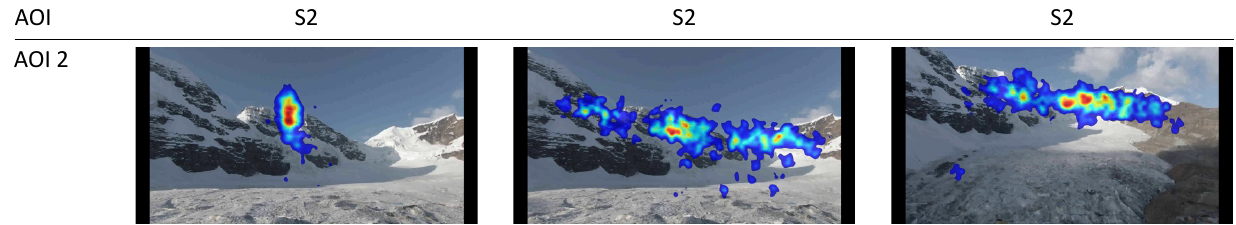
Table 8. Heat maps of the stimuli. AOI S2